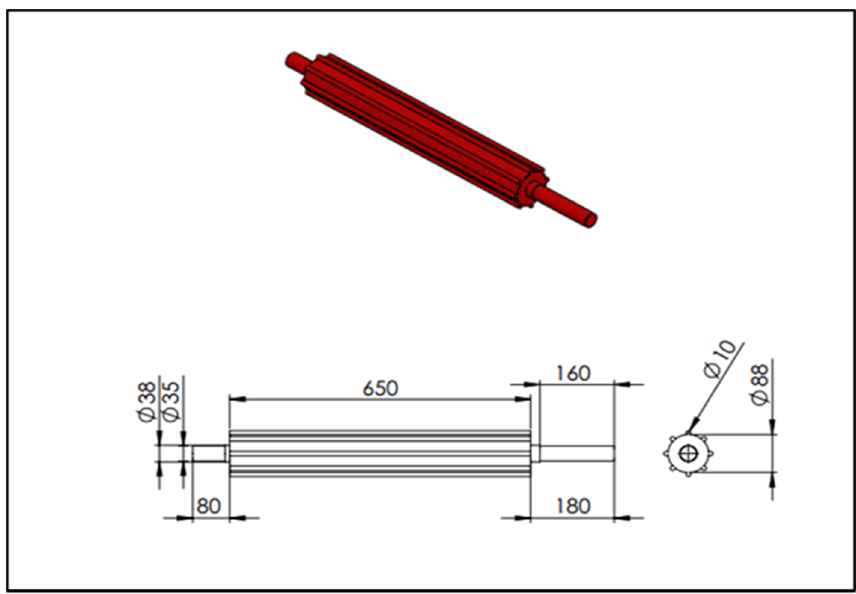
Figure 7. Schematic views of the grabbing rollers of the Aashkol .